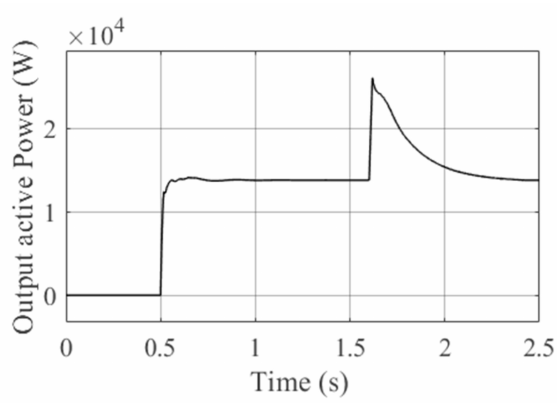
Figure 23. Output active power of the